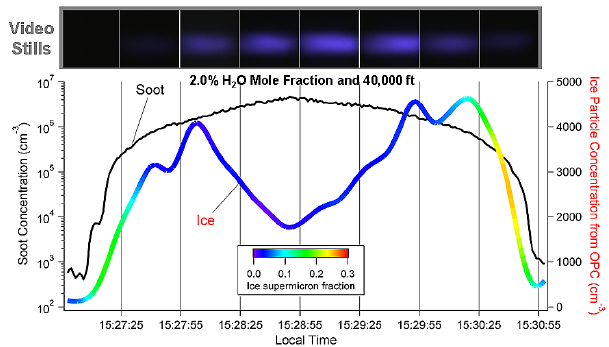
Fig. 5. The OPC measured ice particle concentration and ice super- micron fraction along with video snap shots during a soot concen- tration